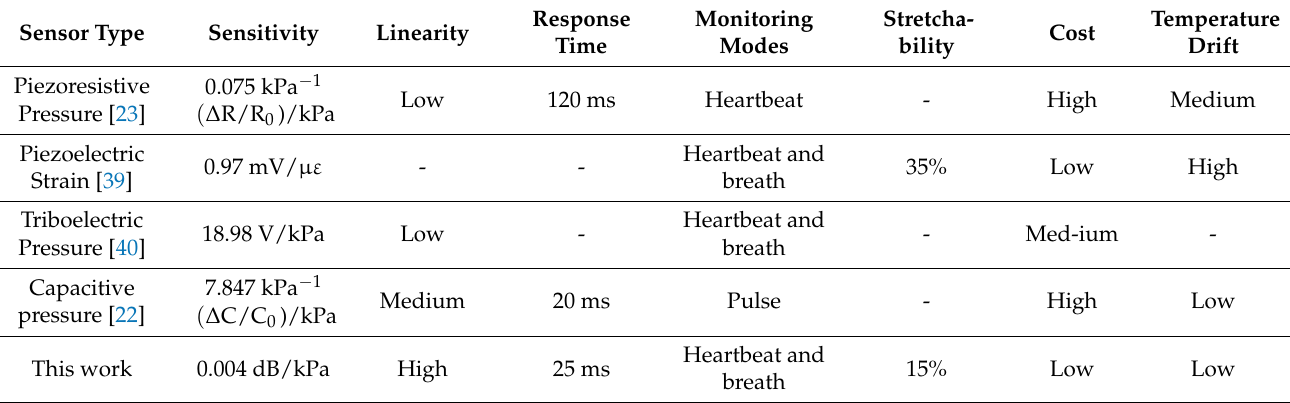
Table 1. Comparison between various pressure sensors for heart rate and respiration monitoring.